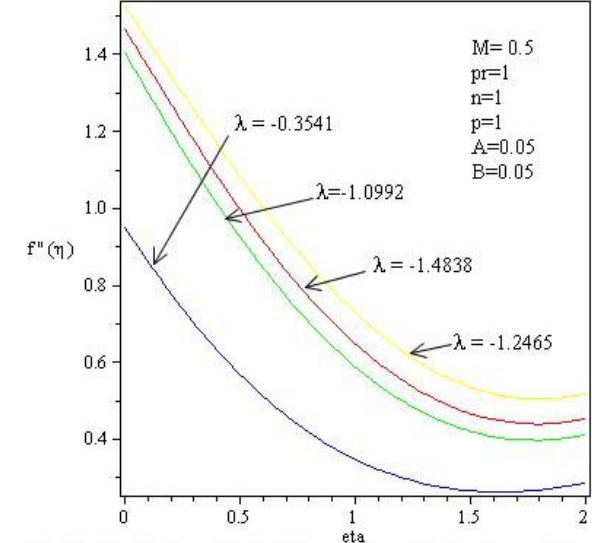
Fig. 9: Combined profile of power law index for flow and velocity for